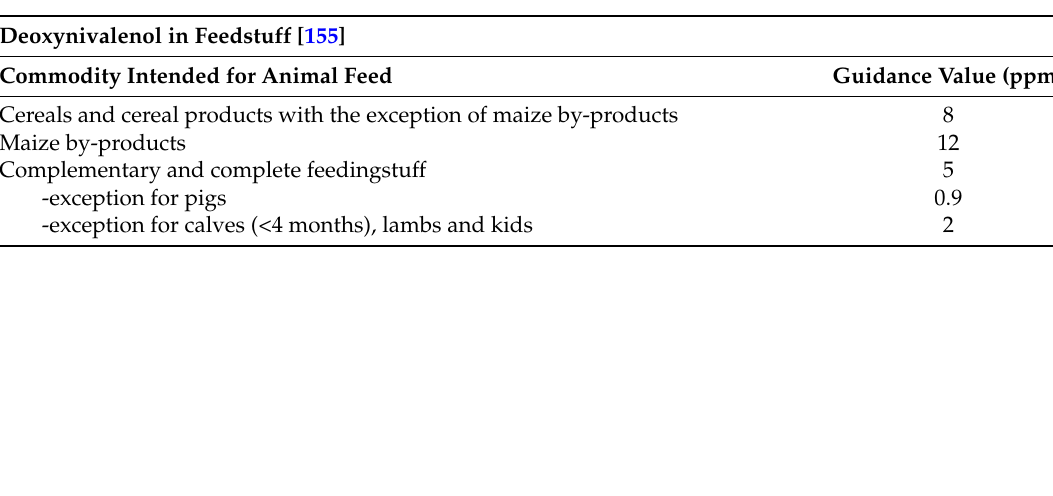
Table 6. Limits relate to cereals intended for animal feed according to European